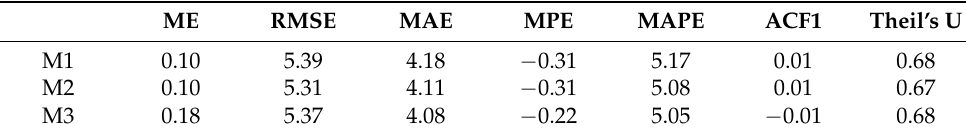
Table 9. The psychiatrist’s hybrid model accuracy measures.